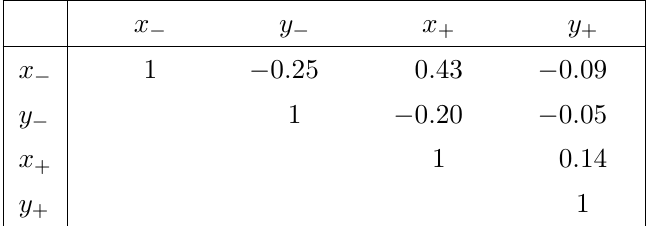
The nonuniform e(cid:14)ciency pro(cid:12)le over the Dalitz plot means that the values of ( c appropriate for this analysis can di(cid:11)er from those measured by the CLEO collaboration, which correspond to the constant-e(cid:14)ciency case. Amplitude models are used to calculate the values of c and s both with and without the e(cid:14)ciency pro(cid:12)les determined from i i simulation. The models are taken from ref. [23] for D ! K 0